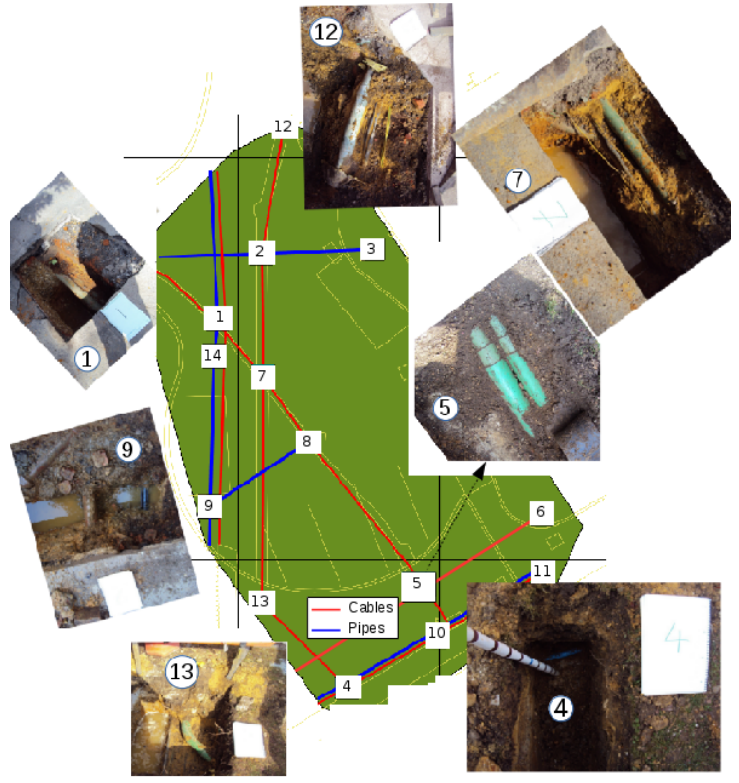
Figure 10. Test site with pictures of dug pits and the ground truth of buried utilities including cables (red lines) and main pipes (blue lines) provided by excavations after all sensor